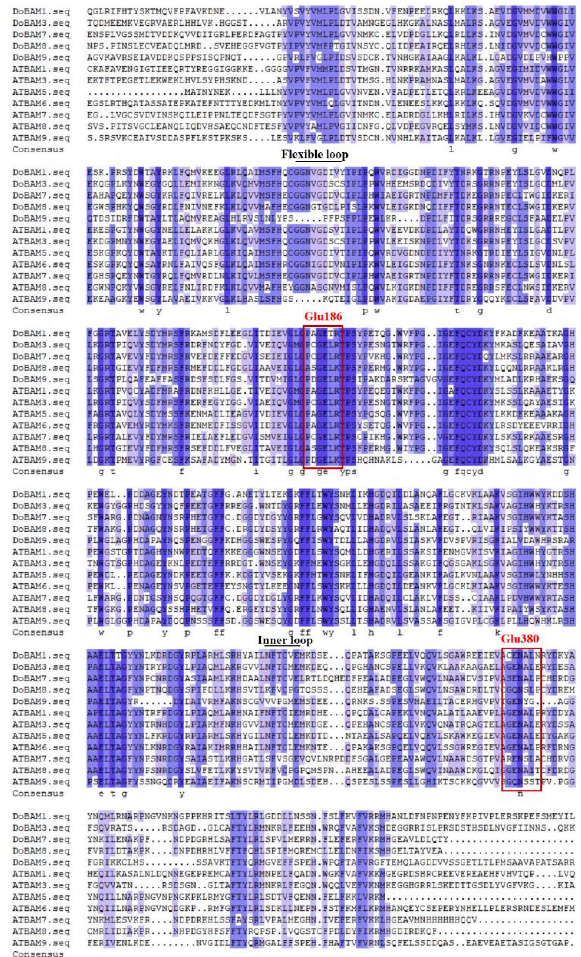
Figure 5. Multiple sequence alignment of DoBAM amino acid family. Blue shading indicates highly conservative substitutions. The two red boxes highlight the catalytic residues Glu-186 and